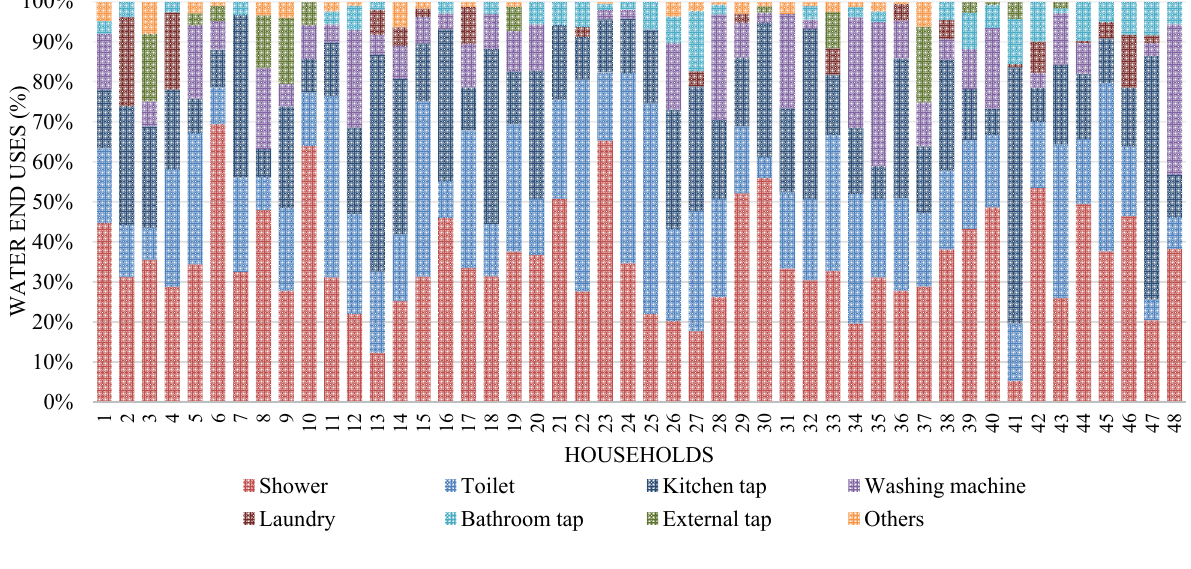
Figure 5. Water end uses in households sample.